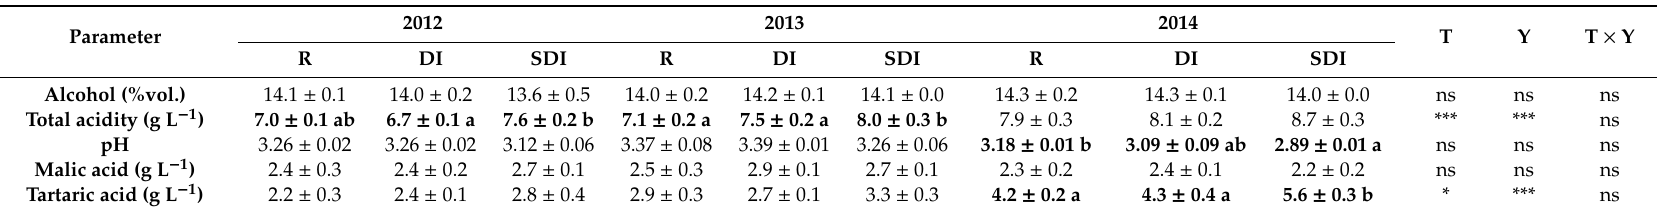
For each year, di ff erent letters indicate significant di ff erences between treatments at p < 0.05. The significance of the year, treatment and their interaction is expressed as ns = not significant; * p < 0.05; *** p < 0.001. Bold letters indicate significant di ff erences among treatments for a given parameter and year. R = rain-fed; DI = drip irrigation; SDI = subsurface drip irrigation; T = Treatment; Y =